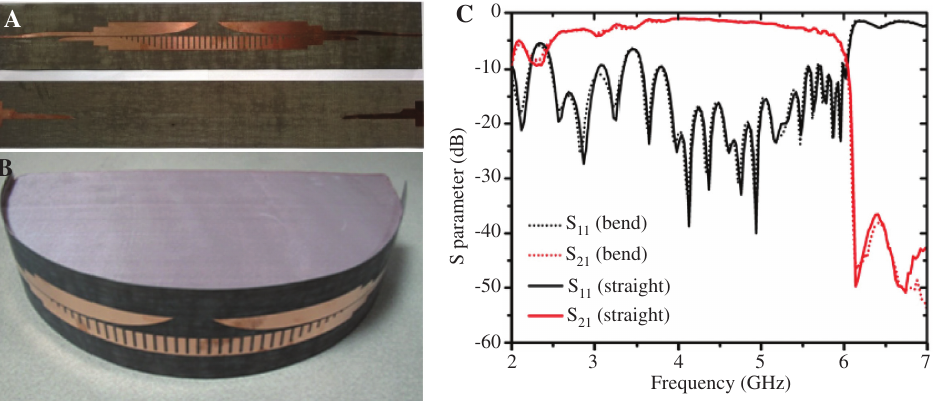
Figure 20: The photos of fabricated sample and measured S parameters. (A, B) The photos of the fabricated samples for the straight and bending SPP waveguides. (C) The measured S parameters for both the SPP waveguides. Reproduced from [45] with